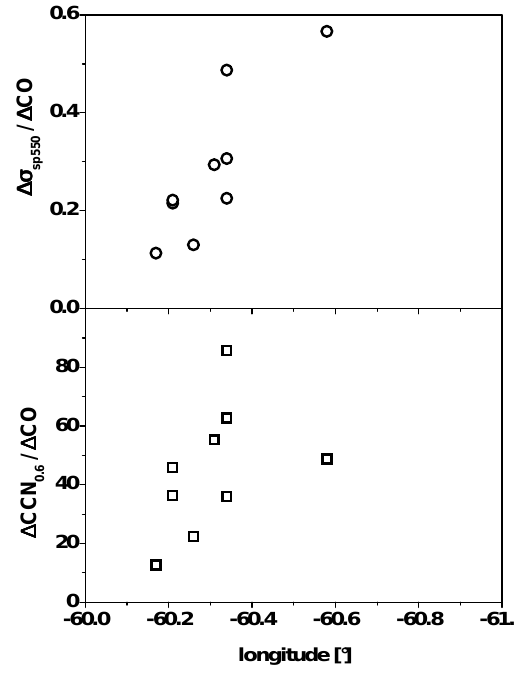
Fig. 13. Light scattering coefficients ( 1σ sp / 1 CO) and CCN 0 . 6 ac- tivity ( 1 CCN 0 . 6 / 1 CO) normalized to CO mixing ratios, as a func- tion of downwind distance (longitude) from Manaus City ( − 3.08 ◦ , − 60.01 ◦ ) during Flight #9. One longitudinal degree corresponds to ∼